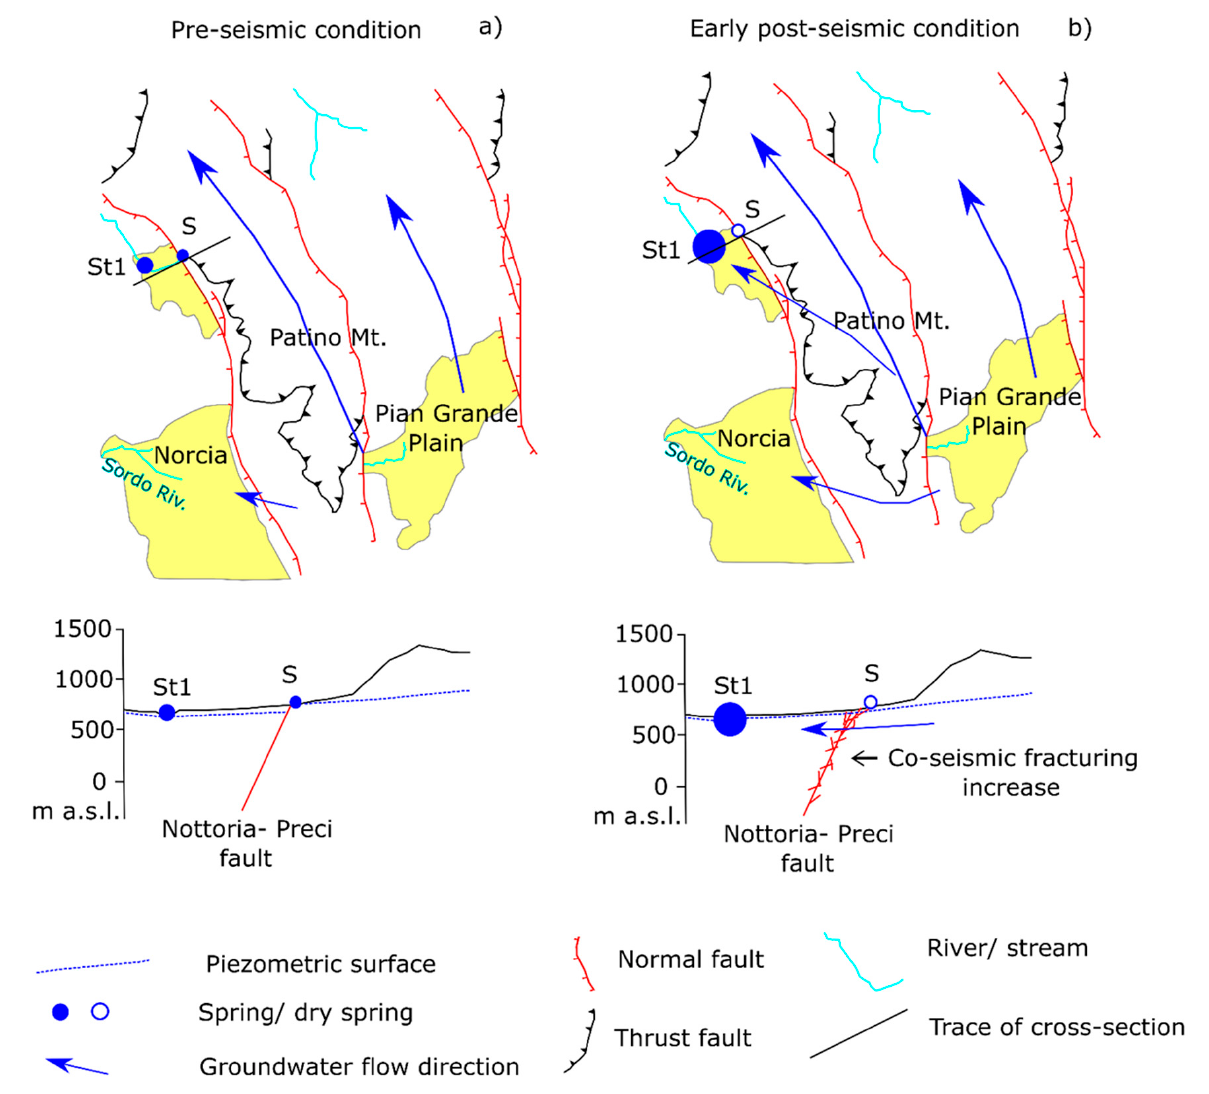
Figure 10. Hydrological conceptual model. ( a ) Pre-seismic condition; ( b ) early post-seismic condi-